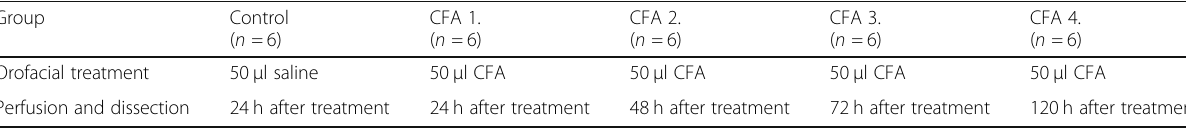
Table 1 Experimental